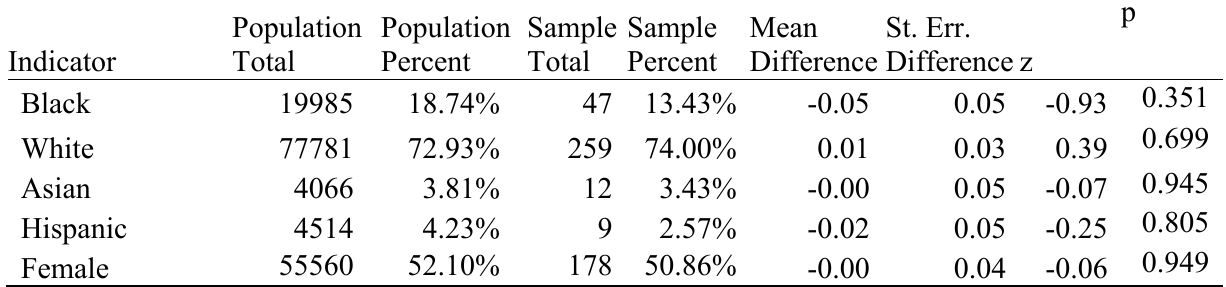
Table A1.2: Nonresponse bias check for sample and population data by census block group based on 2017 data. There were insufficient observations for Native Americans/Native Alaskans and Native Hawaiians in our sample to perform a test of